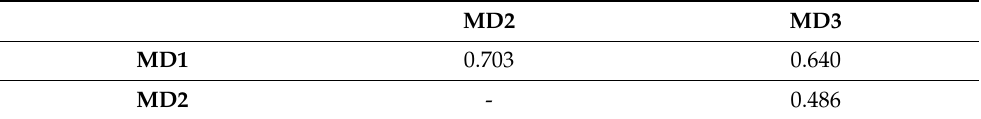
Table 1. Interclass Correlation Coefficient between the three observers before analyzing the 3D printed model.